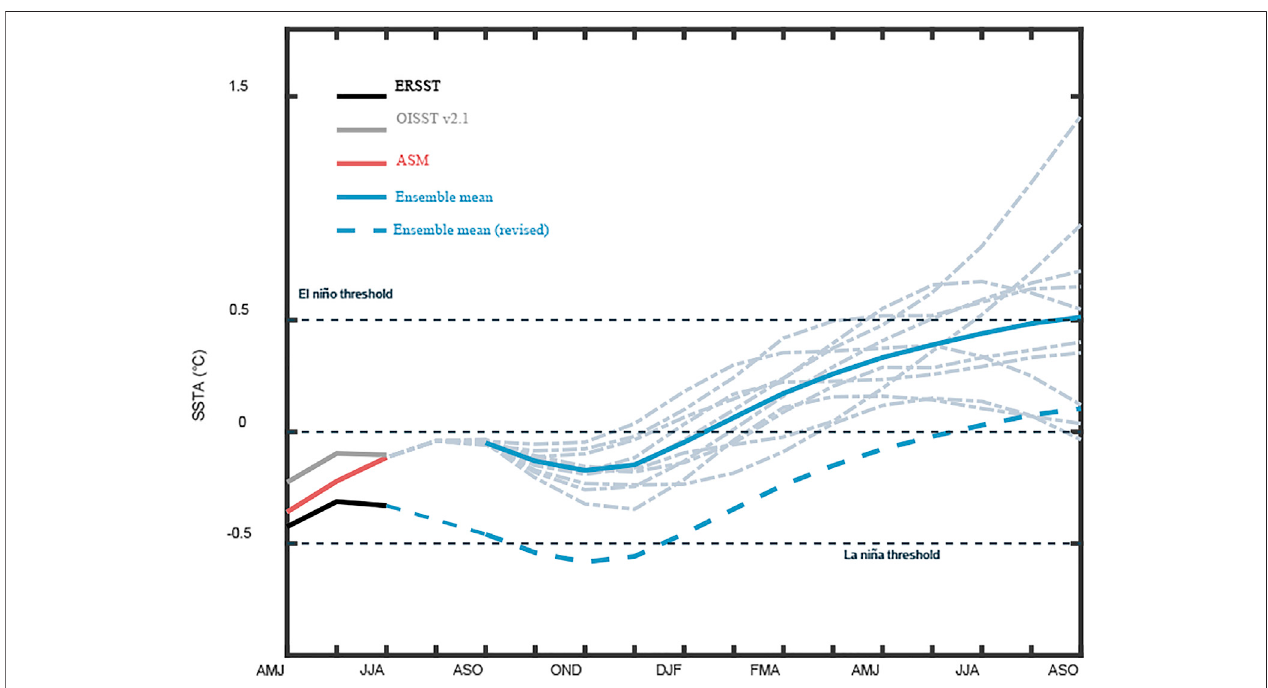
FIGURE 9 | The Niño 3.4 index with respect to the 1982 – 2020 climatology based on the prediction starting from 1 September 2021. The black, grey and red lines are the index of ERSST, OISST v2.1 and the initial state. The blue solid and dashed lines show the prediction of ensemble mean and revised index, and the dashed light blue line represents each